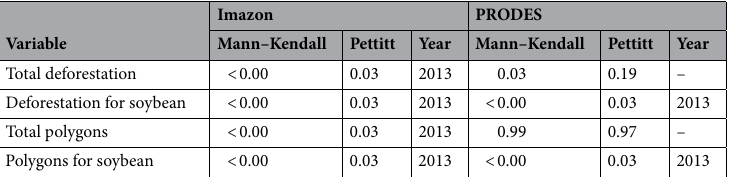
Table 1. P-value of the Mann–Kendall and Pettitt tests for the variables total deforestation, deforestation for soybean planting, total polygons, and polygons for soybean planting obtained from the Imazon and PRODES monitoring